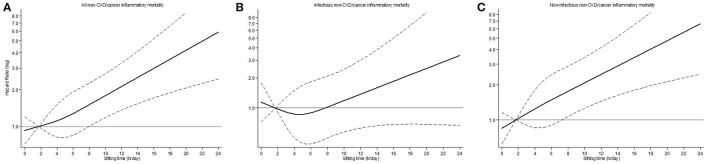
Hazard ratio and 95% confidence interval for mortality for inflammatory causes according to sitting time in older adults: (A) All-inflammatory causes. (B) Infectious inflammatory causes. (C) Non-infectious inflammatory causes. Footnotes: estimates are from Cox regression models of inflammatory, infectious inflammatory and non-infectious inflammatory causes mortality against a restricted cubic spline of sitting time with knots at 2, 4.14, and 8. The black line plots the hazard ratio, and the dashed lines indicate the upper and lower 95% confidence limits. Analyses were adjusted for age (years), sex (male/female), educational level (no formal studies/Primary studies/Secondary or higher studies), smoking (never smoker/ former smoker/current smoker), alcohol consumption (never drinker/former drinker/moderate drinker/heavy drinker), body mass index (kg/m2), chronic lung disease (no/yes), cardiovascular disease (no/yes), diabetes mellitus (no/yes), Parkinson (no/yes), cancer (no/yes), and physical activity (inactive or less active/moderately active/very active).